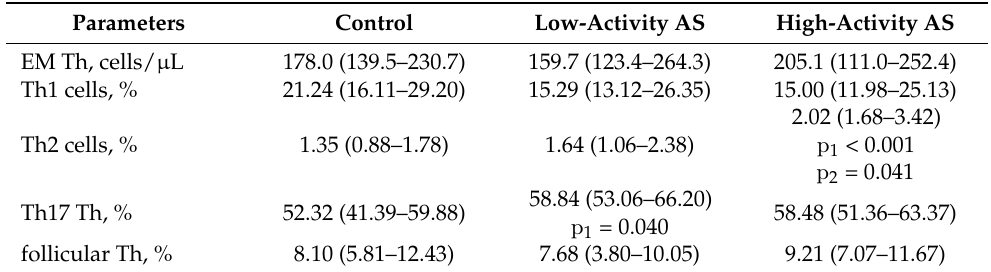
Table 5. Peripheral blood chemokine receptor-based EM Th-cell subset composition in activity-driven AS patients ( Ме (C 25 –C 75 )).